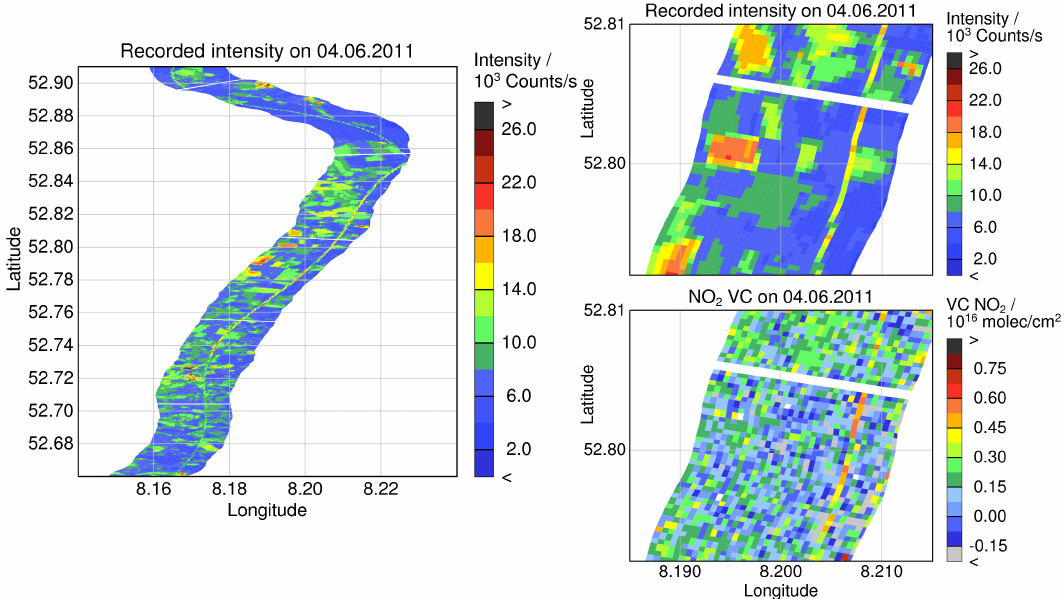
Figure 19. Flight section along the motorway A1 in north-west Germany. The recorded intensity (left) is enhanced above the motorway and in addition above bright fields. The two maps on the right show an excerpt of the flight section, the recorded intensity (top) and the NO 2 VC (bottom). The reflected intensity is enhanced above the motorway and even more above a field on the western side of the swath. NO 2 amounts above the motorway are also enhanced, but not above the bright